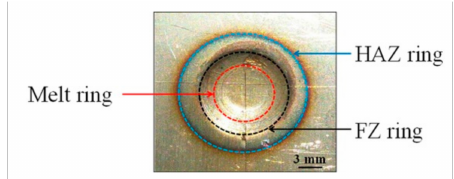
Figure 2. Appearance of the SUS316L / SUS425 resistance spot welded joint.